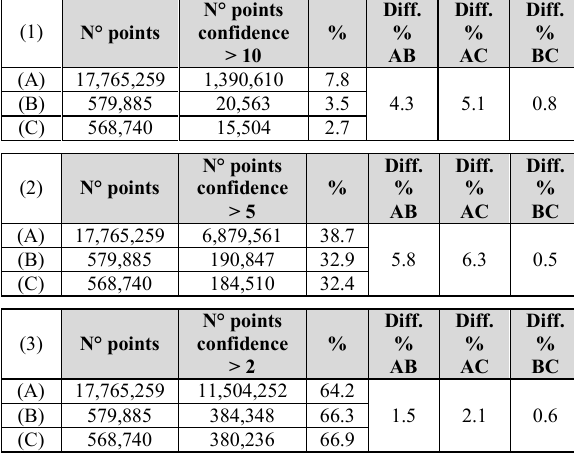
Table 7 . Molini Allioni rural chapel dataset point cloud analysis. N° of points with confidence greater than 10 (1), 5 (2) and 2 (3) for: (A) visible dataset, (B) thermal dataset